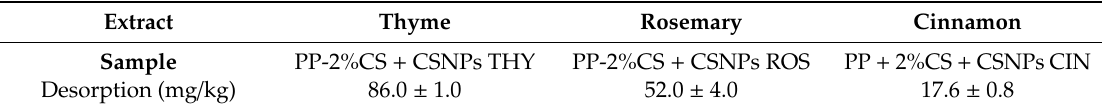
Table 5. Desorption of extracts per kg of PP foil.